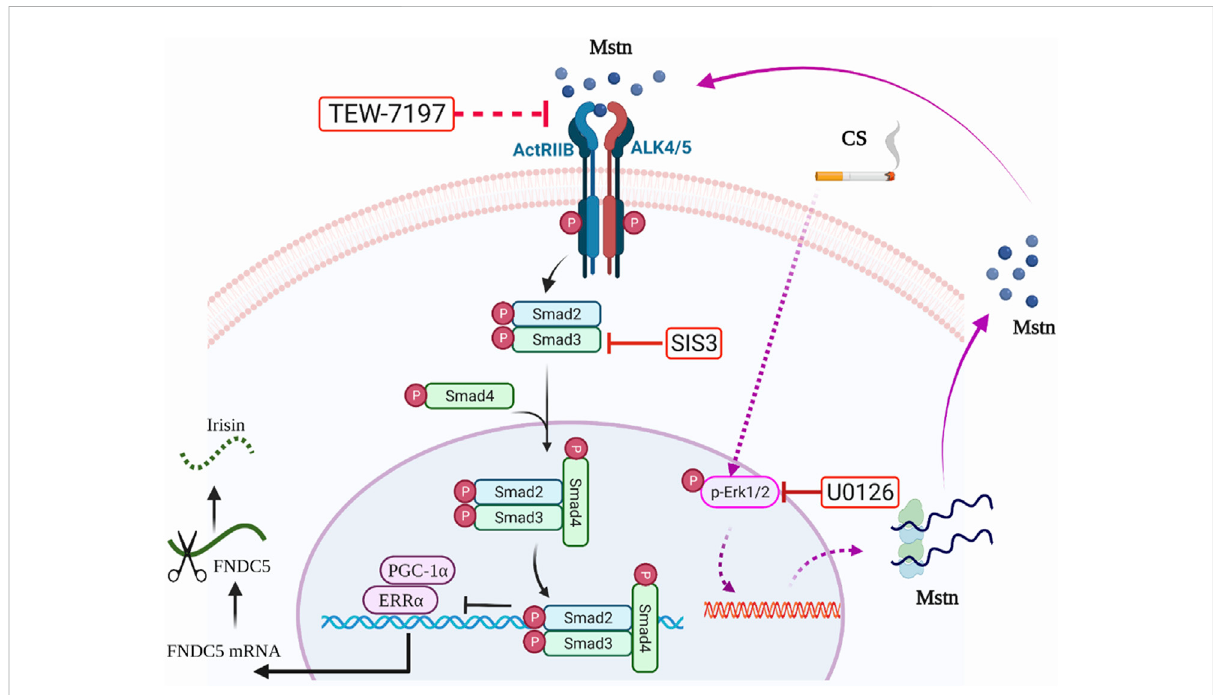
FIGURE 6 Graphic summary. On the one hand, cigarette smoke extract (CSE) exposure could enhance myostatin (Mstn) production through the Erk1/ 2pathway,whichfurtheractivatedtheSmad3/PGC-1 α pathway,andnegativelyregulatedFndc5production.Ontheotherhand,CSEexposuremight partially and directly decrease the expression of Fndc5. TEW-7197, a selective TGF- β receptor ALK4/ALK5 inhibitor that can stop Mstn binding to its receptor.SIS3,aspeci fi cSmad3 inhibitorbyinhibitingSmad3 phosphorylationto suppressSmad3 signaling pathway.U0126,aspeci fi cinhibitor of